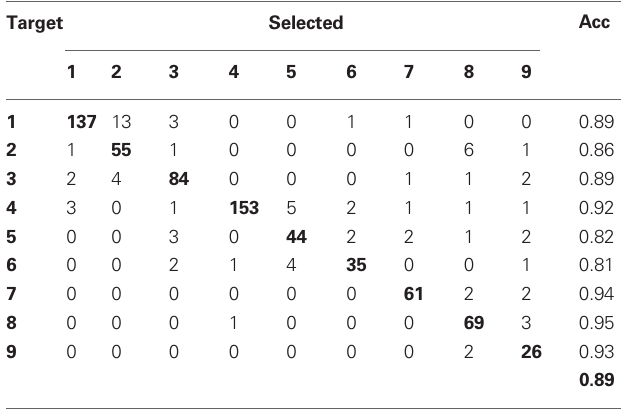
The diagonal elements (correct decisions) are marked in bold. Column “Acc” provides the specific accuracy for each